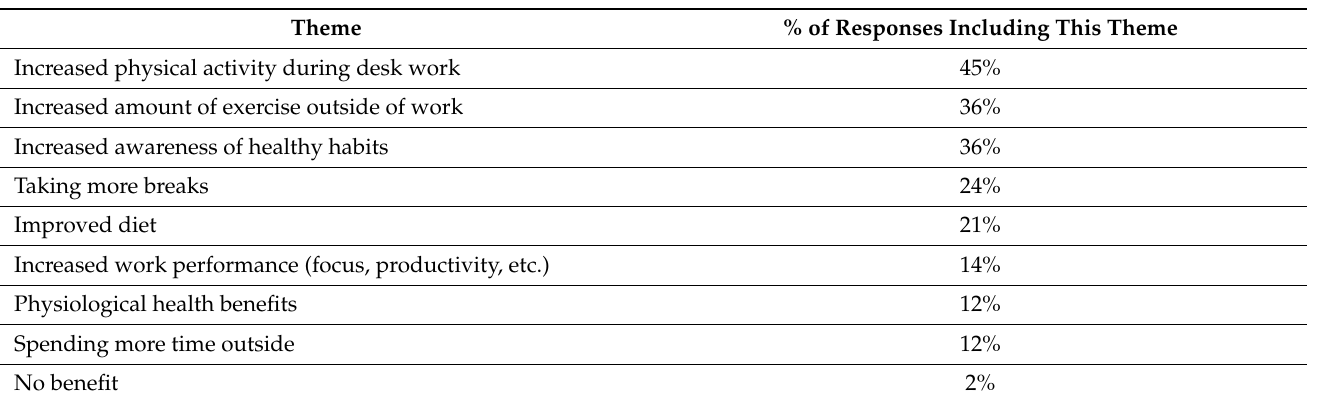
Table 4. Qualitative Analysis of Behavioral Program Benefits on Employee Mental Well-being and Work